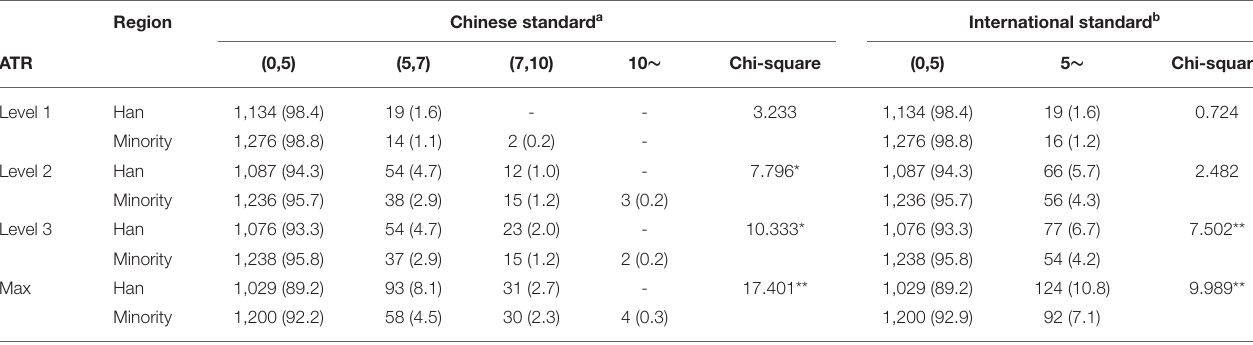
TABLE 2 | ATR values of the study population using two IS standards. Region Chinese standard a International standard b ATR Chi-square